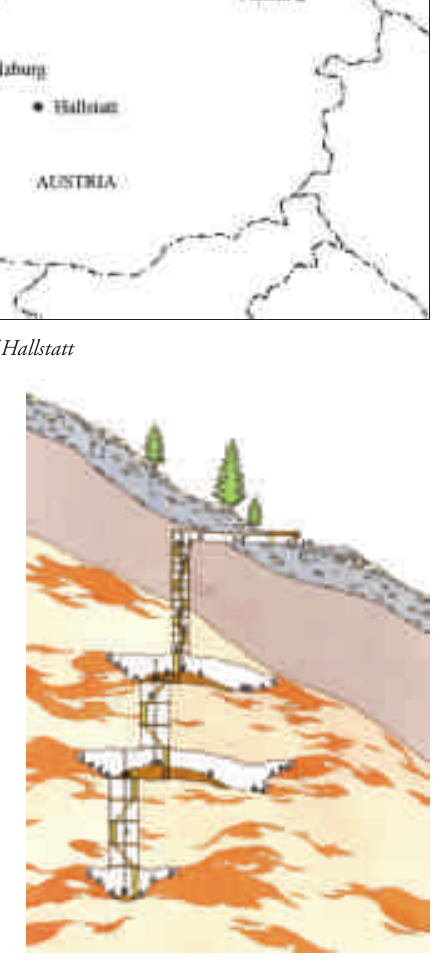
Figure 2 Section through the Christian von Tuschwerk site showing galleries and shafts, based on discoveries from current excvations and historical records